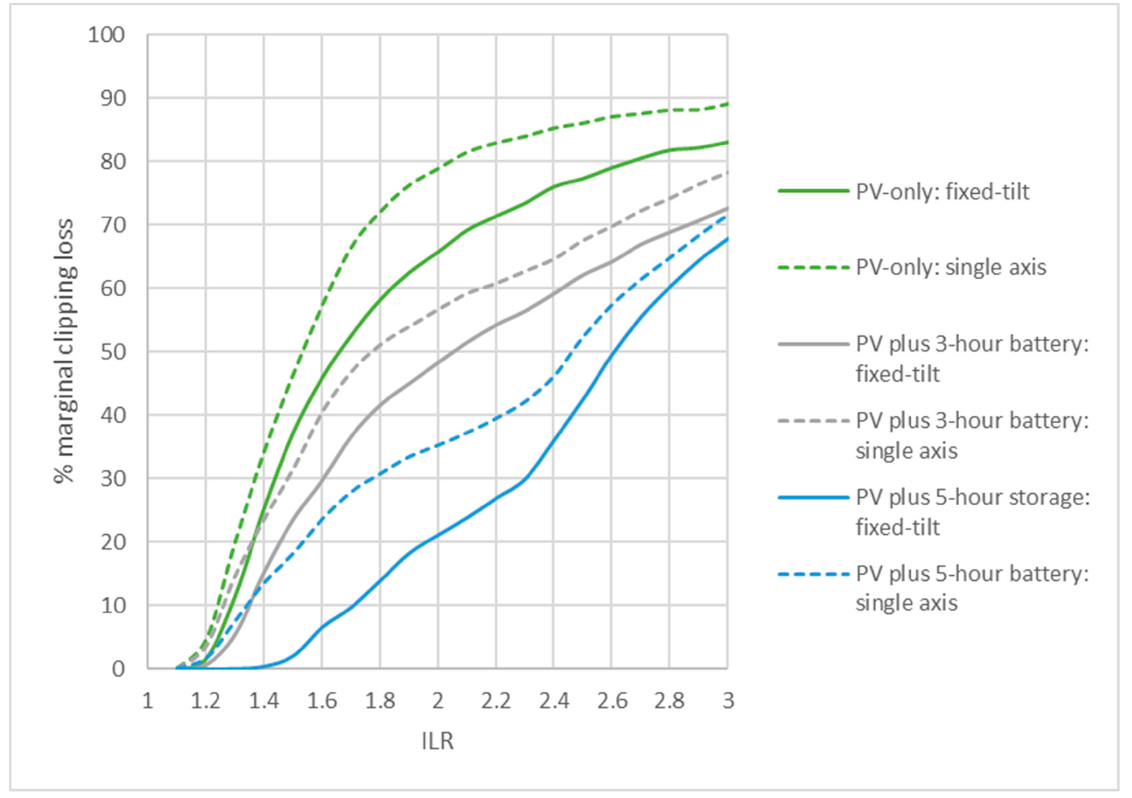
Figure 9. Comparison of % marginal clipping loss between fixed and single axis tracking.